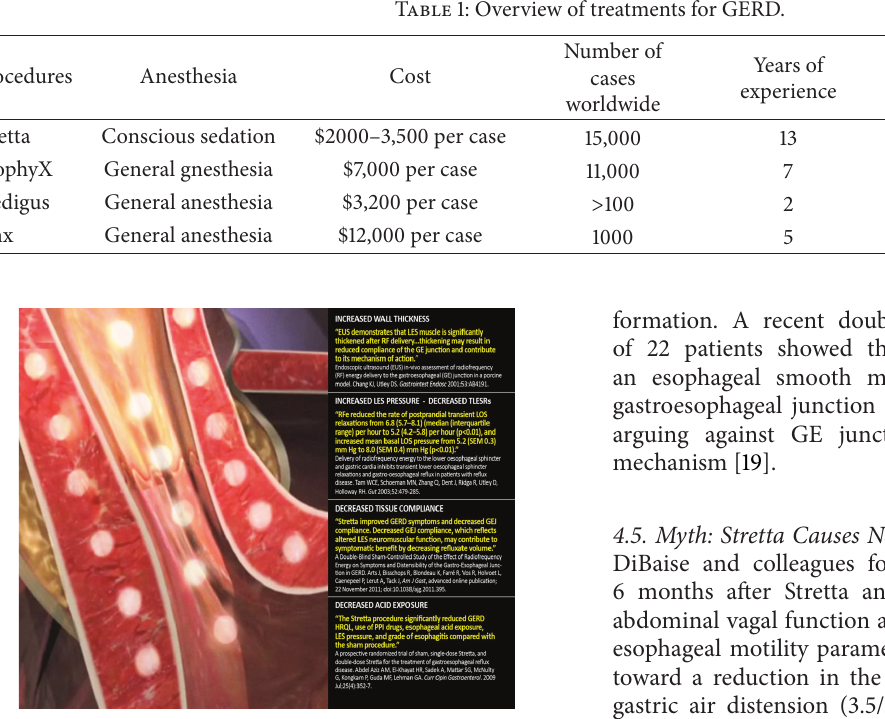
Figure 1: Stretta radiofrequency treatment mechanism of action (with the permission of Mederi Therapeutics, copyright